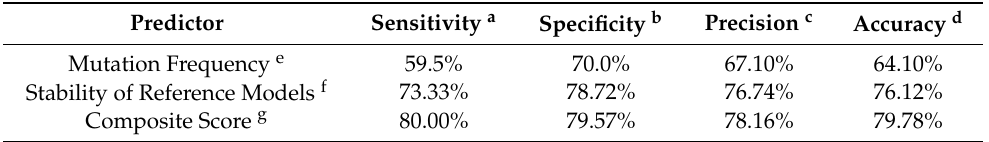
Figure 2. Mutations observed in a database of 5811 HIV-1 capsid sequences. Mutations resulting in non-infectious or infectious viruses are shown separately and stratified based on their database frequencies. White boxes represent the percentage of mutations not found in the database. Table 1. Accuracy of using mutation frequency or change in structural stability to predict viral infectivity in binary classification